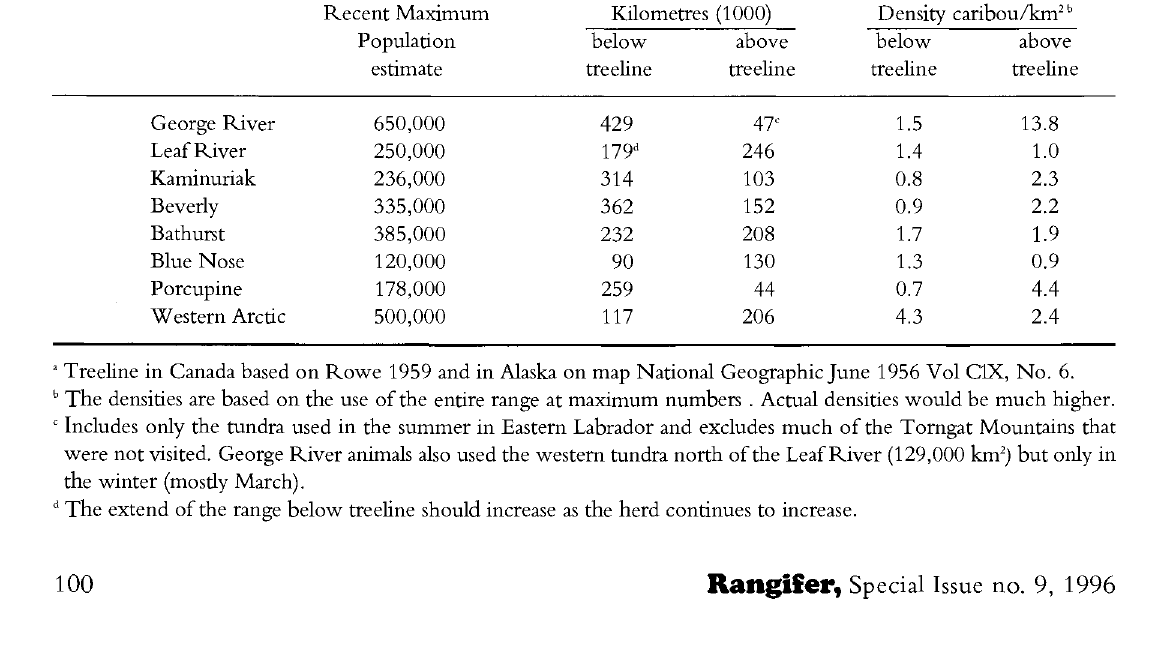
Table 3. A comparison of the densities above and below treeline'for the major migratory herds in North America. Recent Maximum Kilometres (1000) Population below above below above treeline